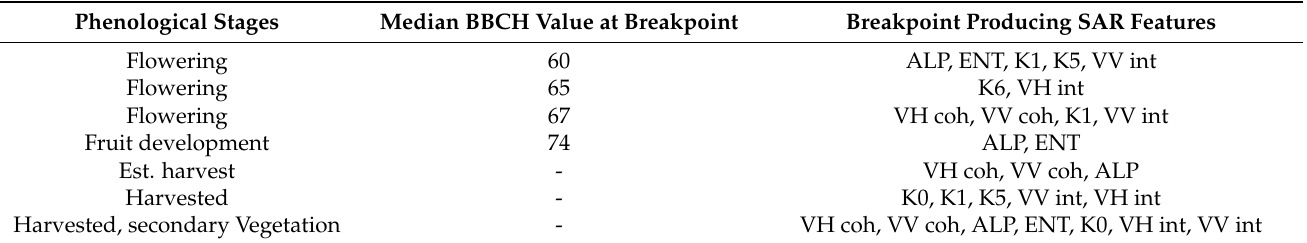
Table 5. Median BBCH values and phenological stages of breakpoints derived from corresponding SAR features in canola